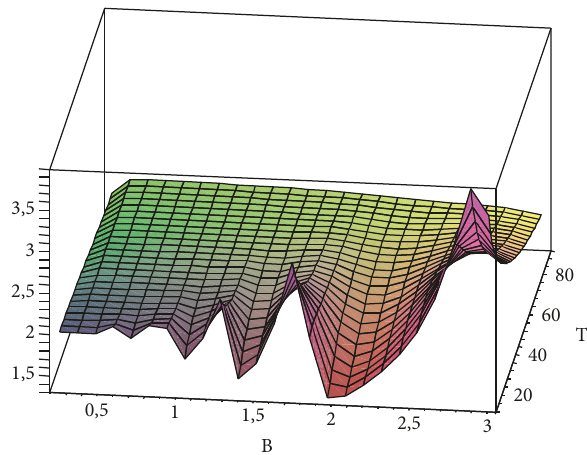
Figure 4: Oscillations 𝑑𝑃/𝑑𝐻 dependence on the magnetic field and temperature in semiconductors with the Kane dispersion law.